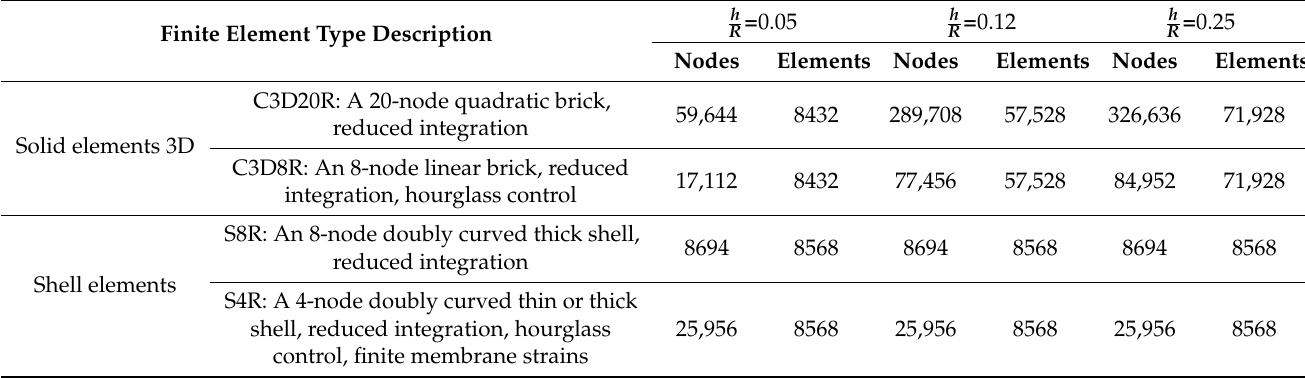
Figure 7. Details of the numerical model in Abaqus. Table 4. Finite element types and statistical